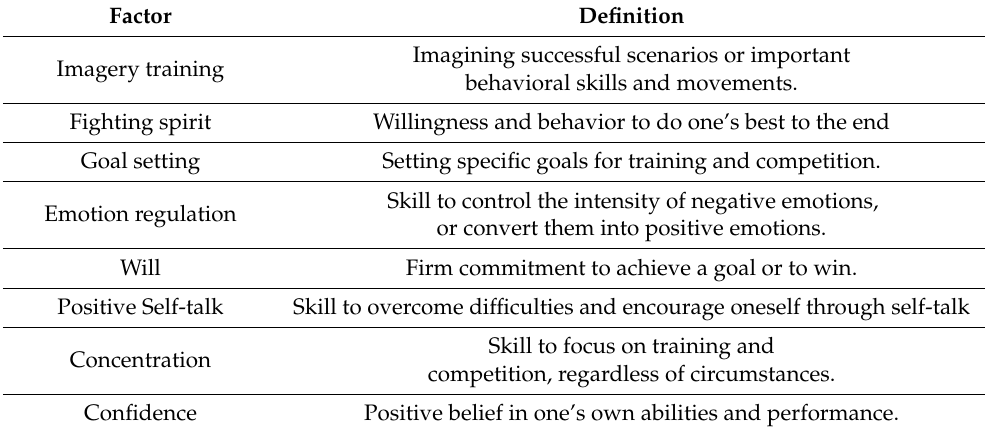
Table 4. Speed Skater’ Eight Key Sport Psychological Skills. Factor